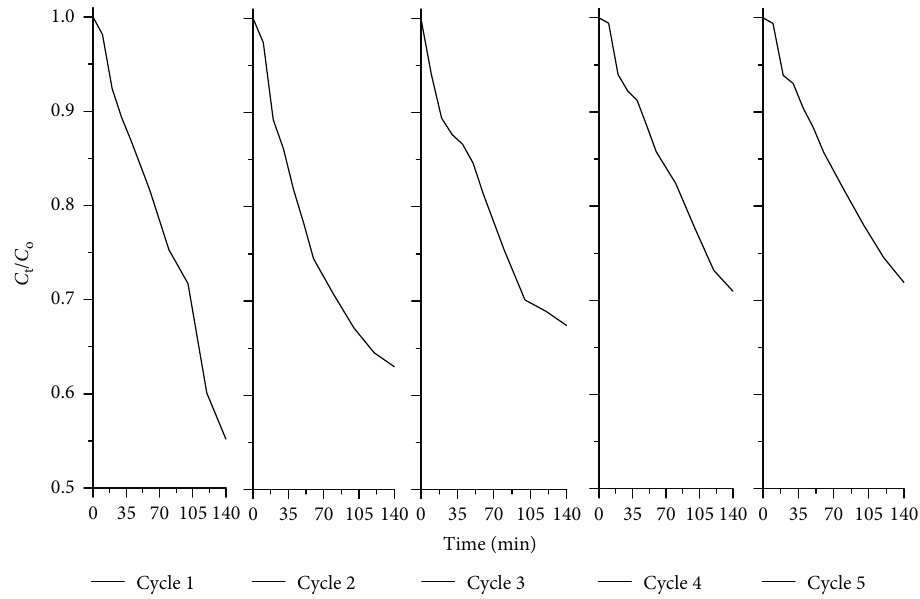
Figure 9: Recycling test for MB photocatalytic degradation under visible irradiation on ZnO:Ag (5%) thin fi